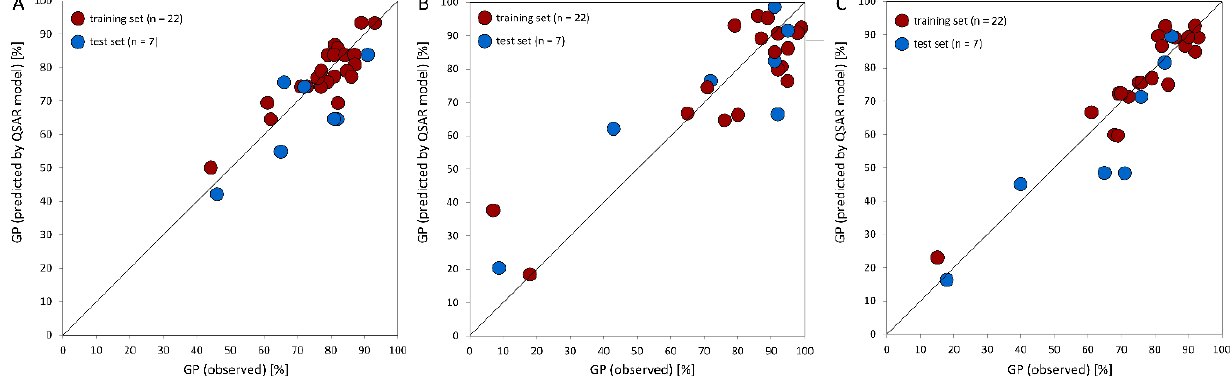
Figure 6. The comparison between growth percent (GP) values observed experimentally and predicted by QSAR models for: MCF-7 ( A ); HeLa ( B ) and HCT-116 ( C ) cell lines. Training and test compounds are shown by red and blue circles,